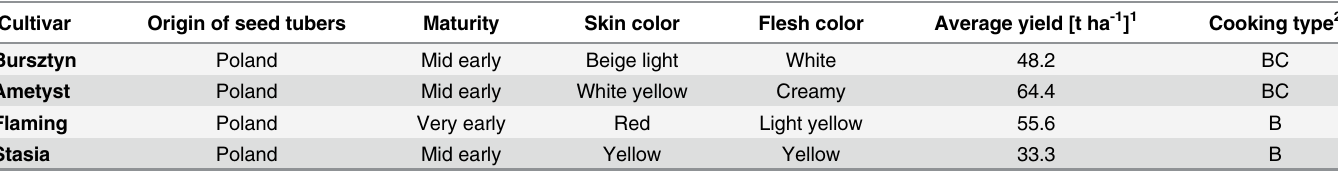
Table 2. Characteristics of potato